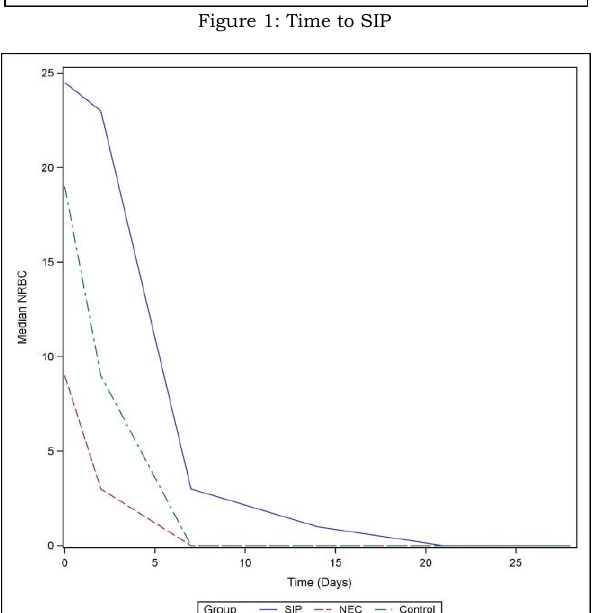
Figure 1: Time to SIP